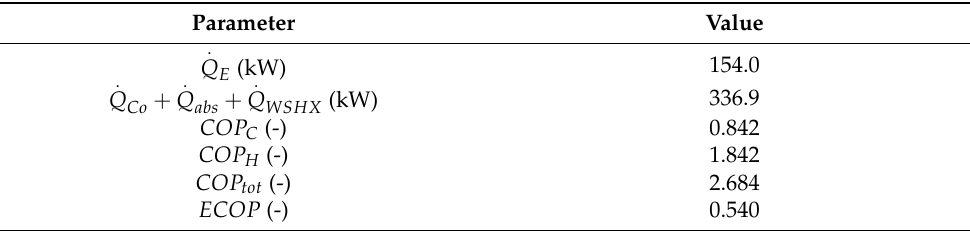
Table 5. Absorption heat pump performance for an indoor swimming pool.